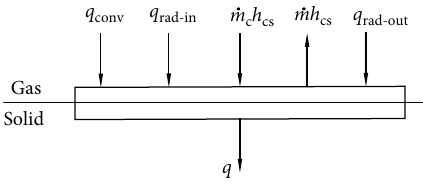
Figure 1: Energy transfer at the gas-solid